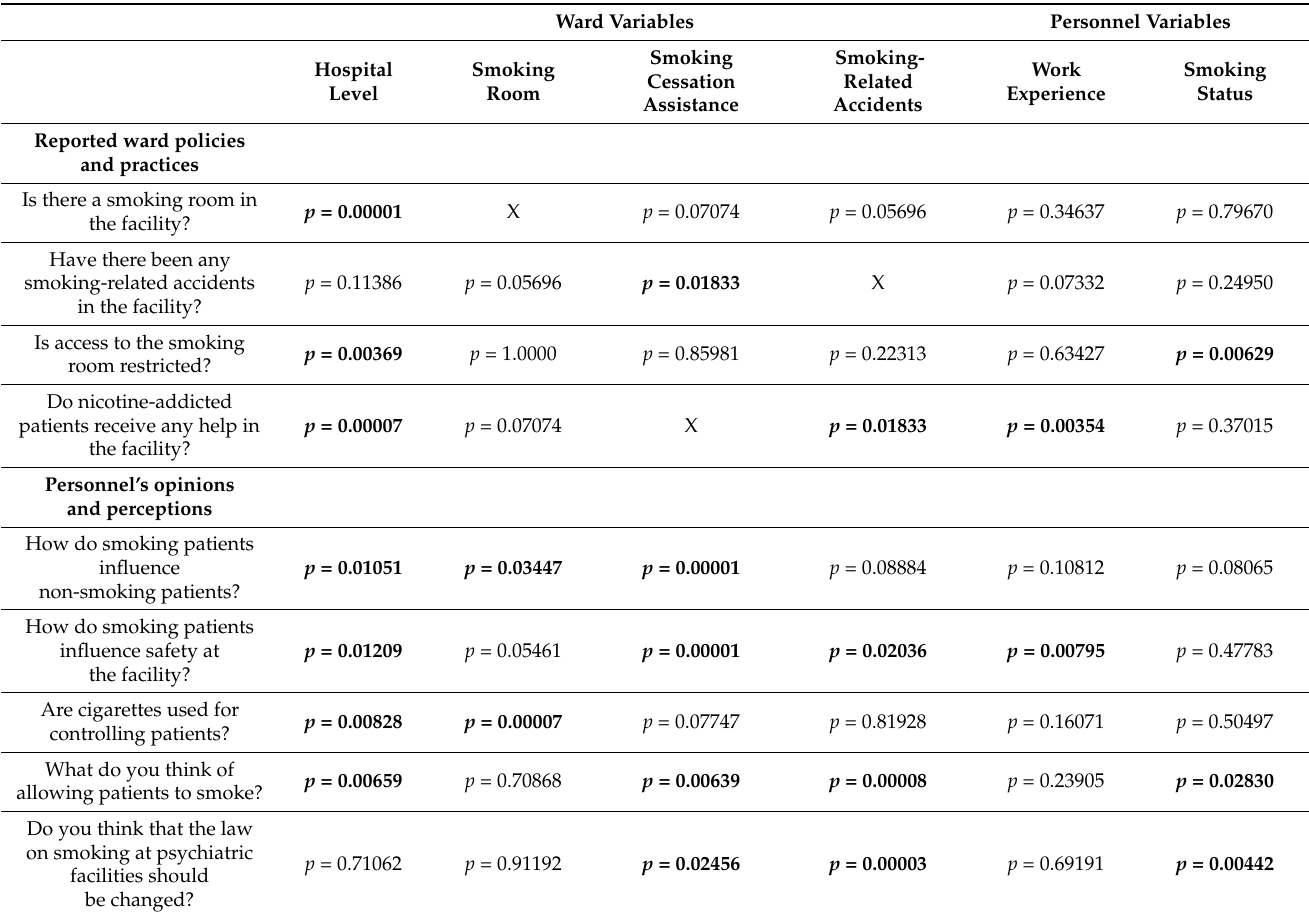
Table 3. Ward policies and personnel’s opinions vs. selected ward and personnel